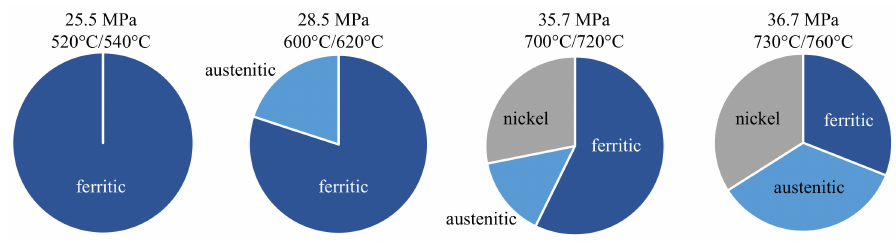
Figure 3. Changes in the streel assortment for power facilities at different steam parameters.